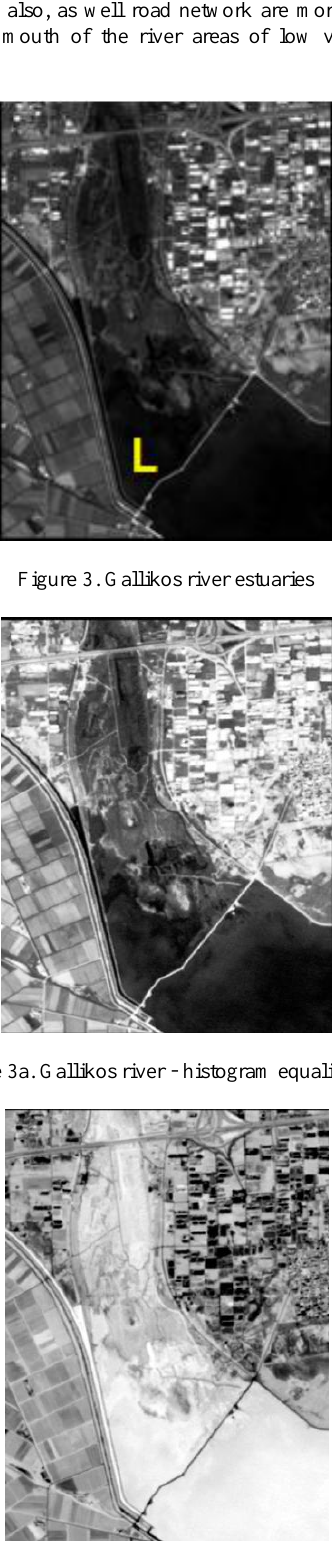
Figure 3b. Gallikos river - brightness